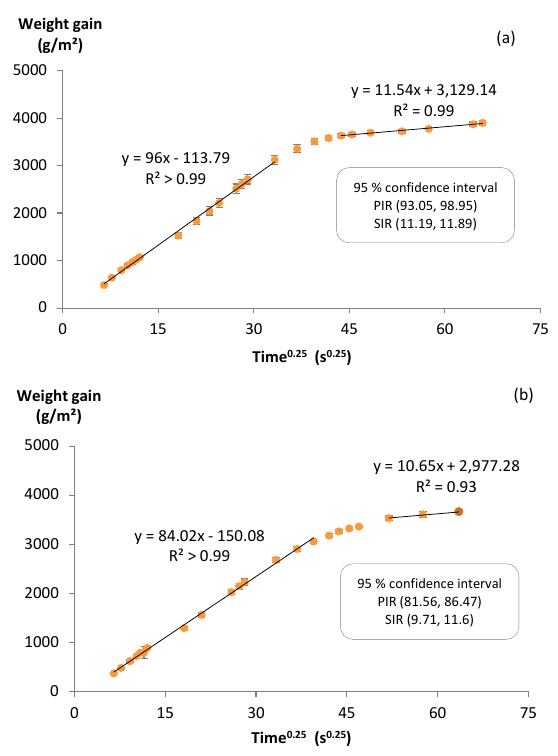
Figure 2. Capillary imbibition rate of Mix 1 at 28 (a) and 91 (b) days of age. The 95 % confidence intervals of the corresponding PIR and the SIR are given between parenthesis.